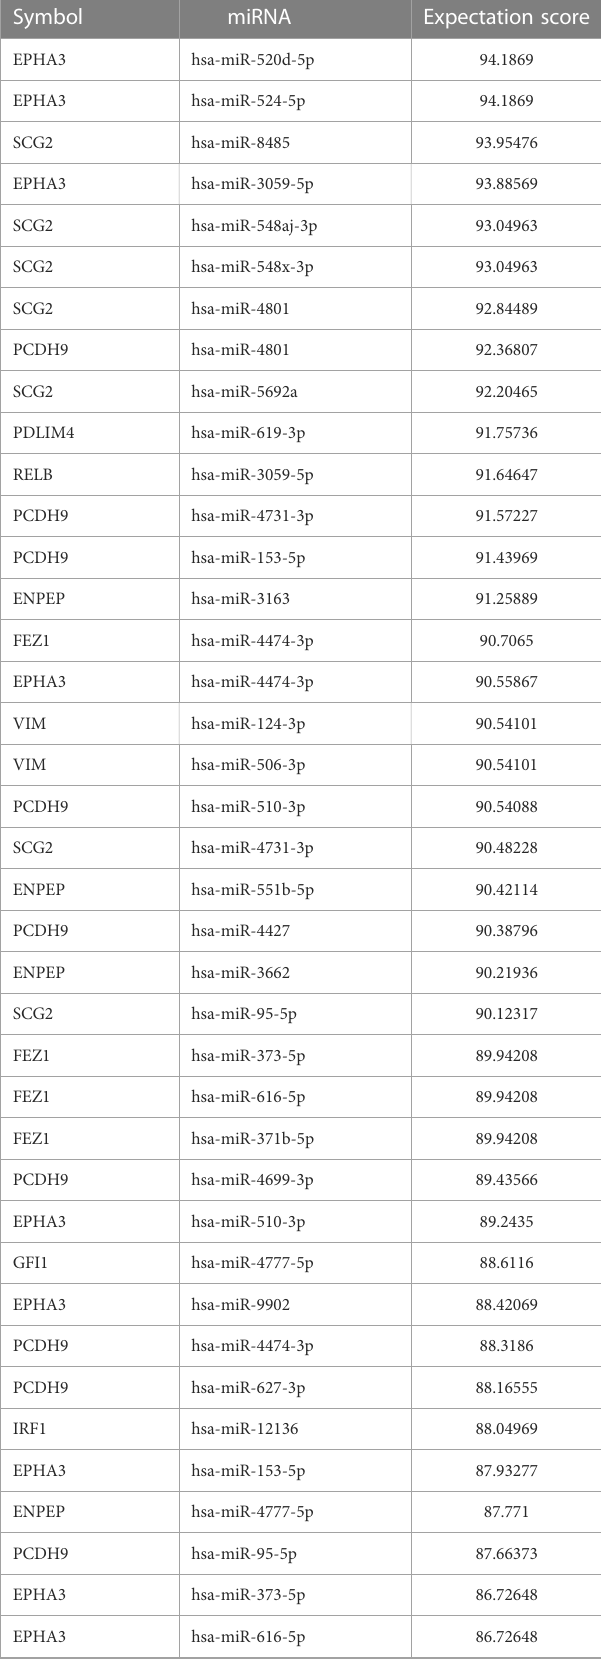
TABLE 2 The list of TarGetScore for TME-associated miRNAs. Symbol